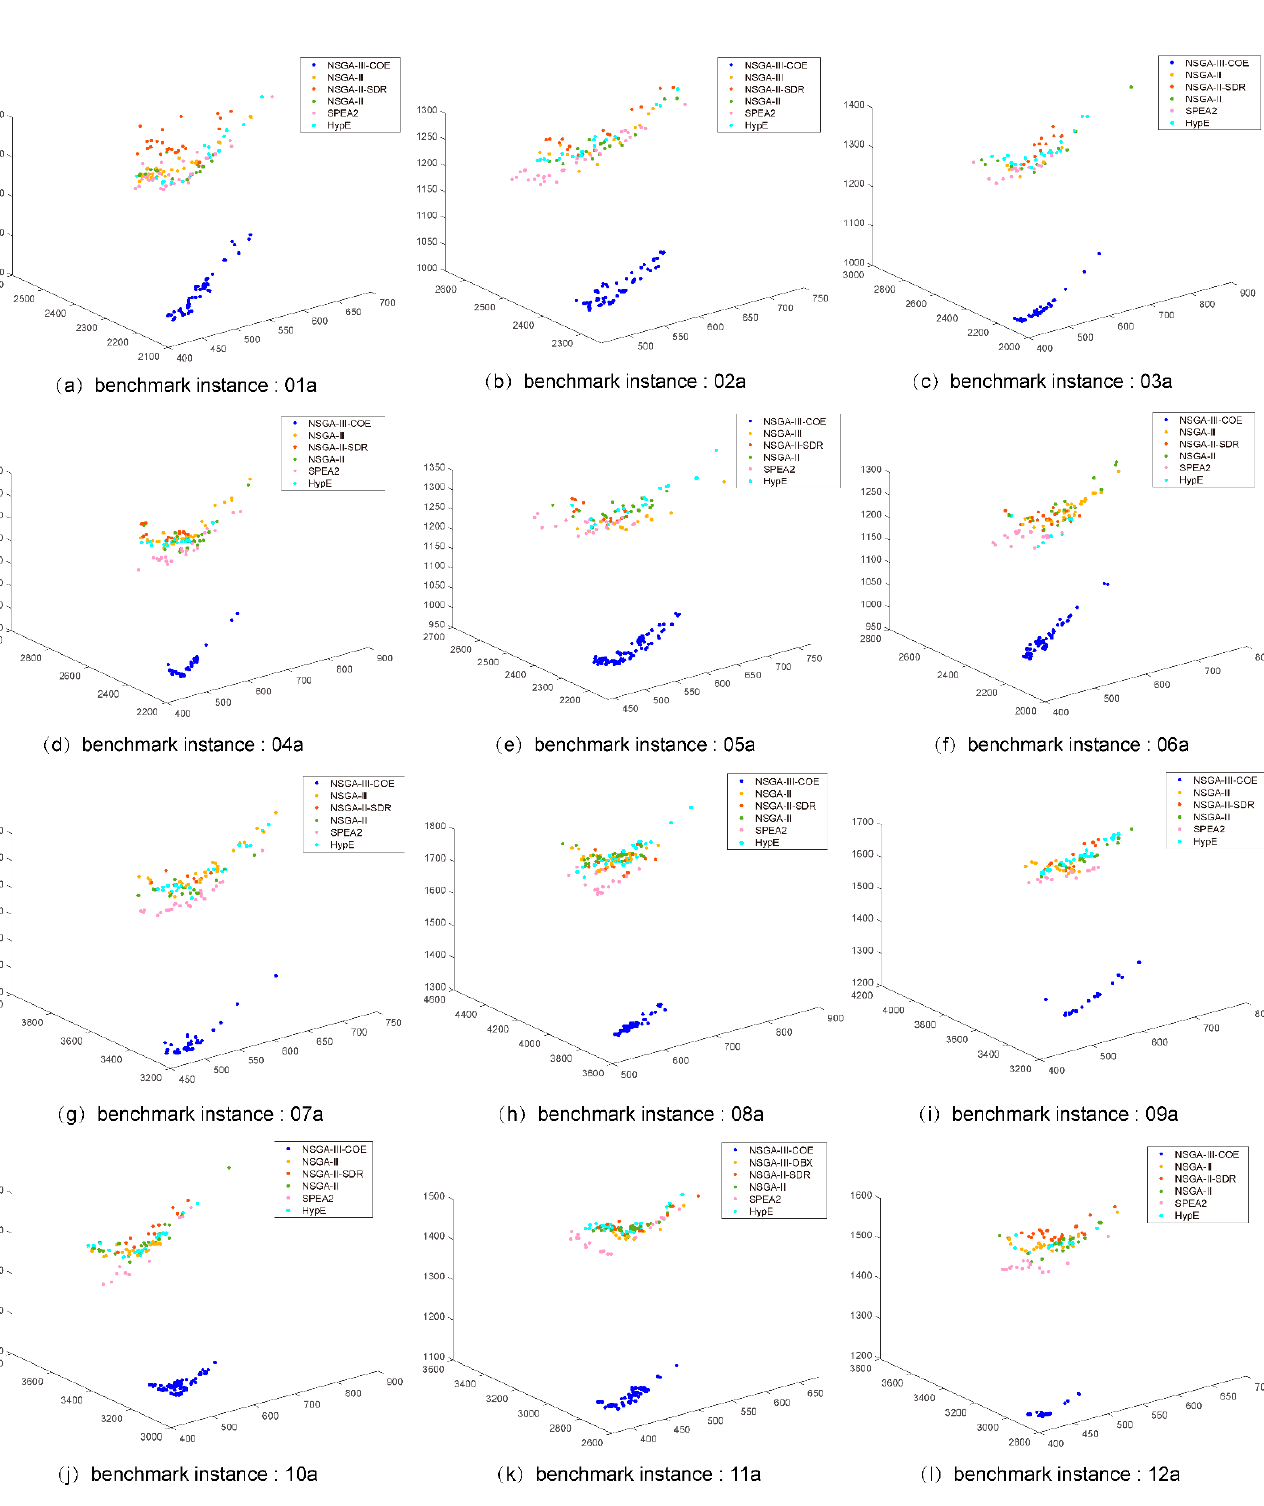
Figure 10. The non-dominated solutions of NSGA-III-COE, NSGA-III, NSGA-II, NSGA-II/SDR, SPEA2, and HypE on instances 01a–12a.